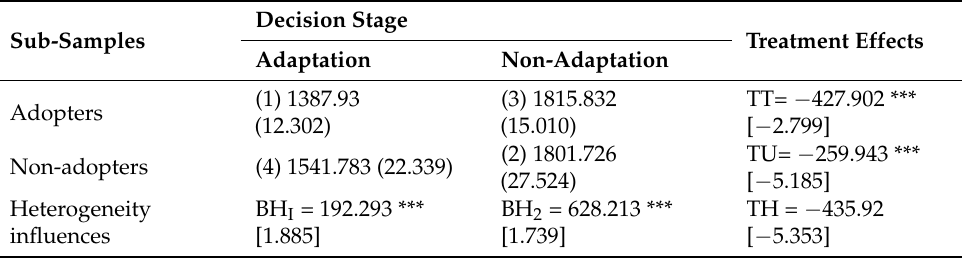
Table 4. Influences of adaptation on projected average maize crop productivity; Treatment and Heterogeneity